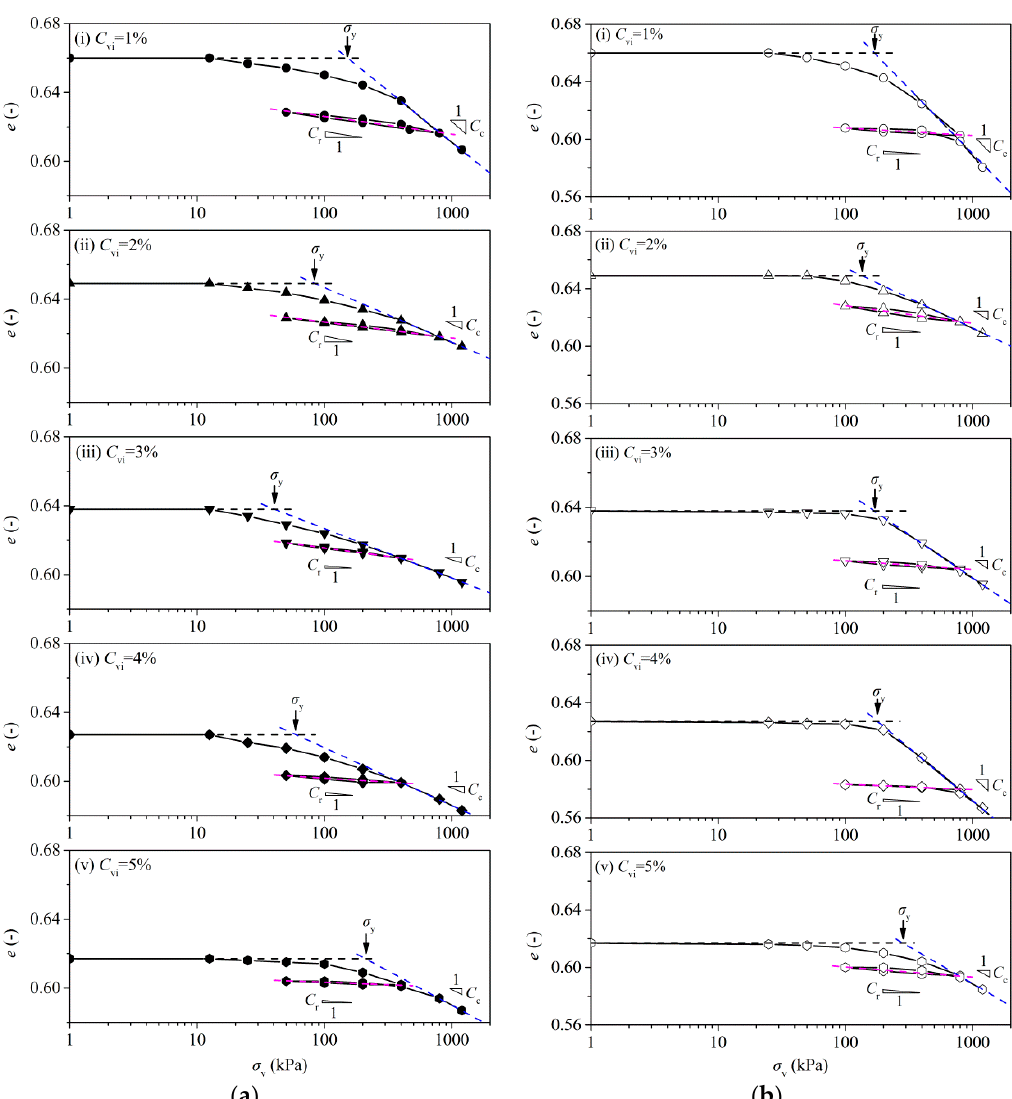
Figure 10. e − log σ v relationship of saturated cement-treated GRS. ( a ) Curing time = 7 d; ( b ) Curing time = 28 d.